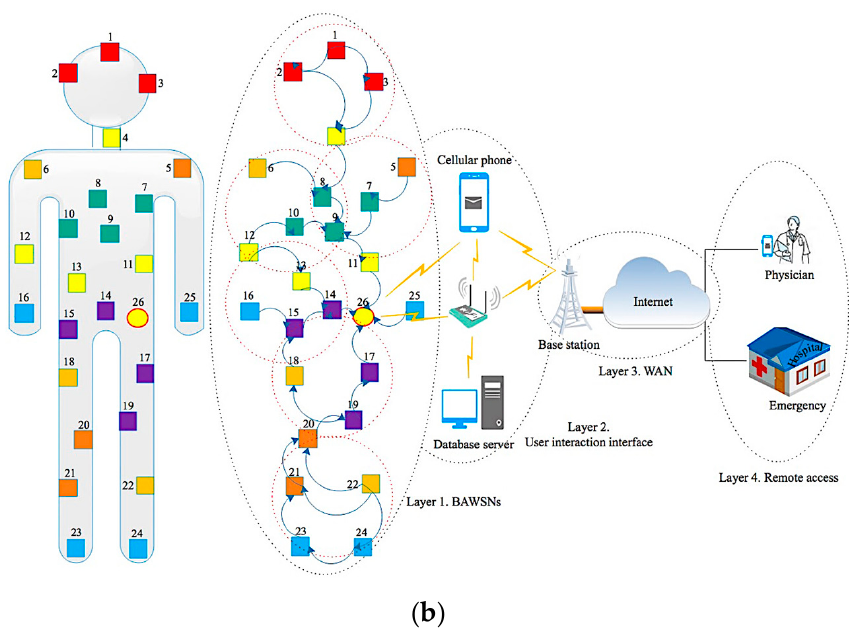
Figure 1. ( a ) A human with implanted biosensors in a remote location. ( b ): Network model for the SARP routing scheme. In which, BAWSNs and WAN indicates the Body Area Wireless Sensor Networks and Wide Area Network, respectively.